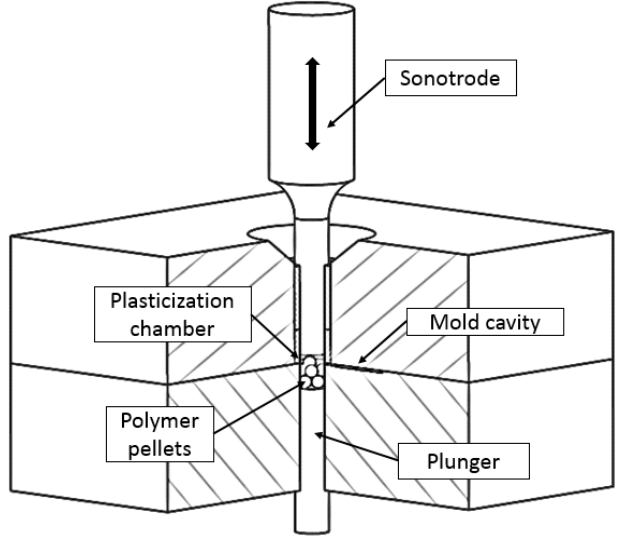
Figure 1. Ultrasonic molding process schema.